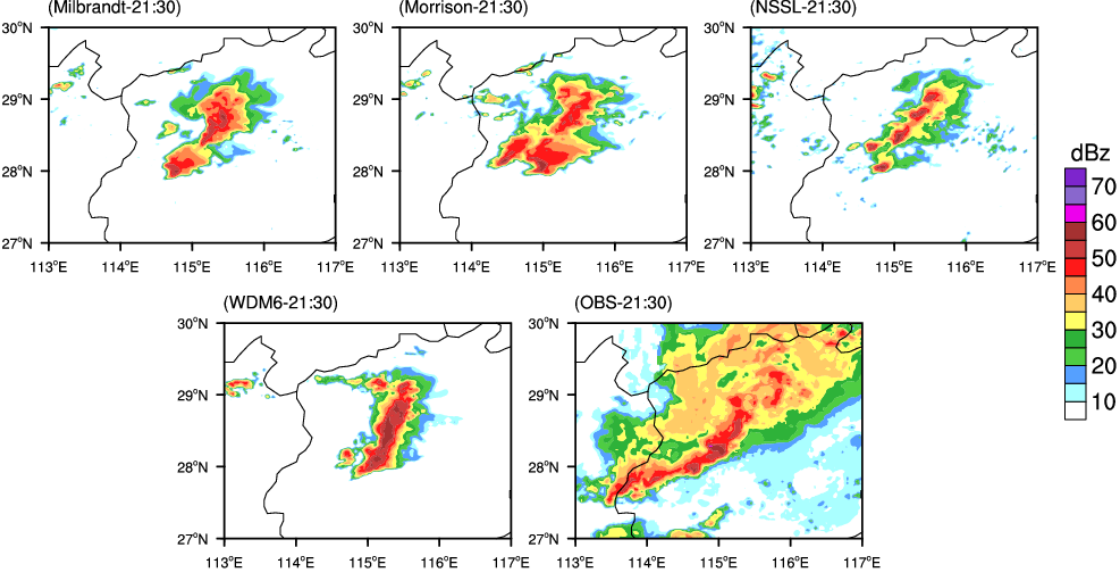
Figure 7. The observed and simulated radar composite reflectivity with different double−moment. MP schemes at 2130 UTC 15 April 2016 (shaded, units: dBz).